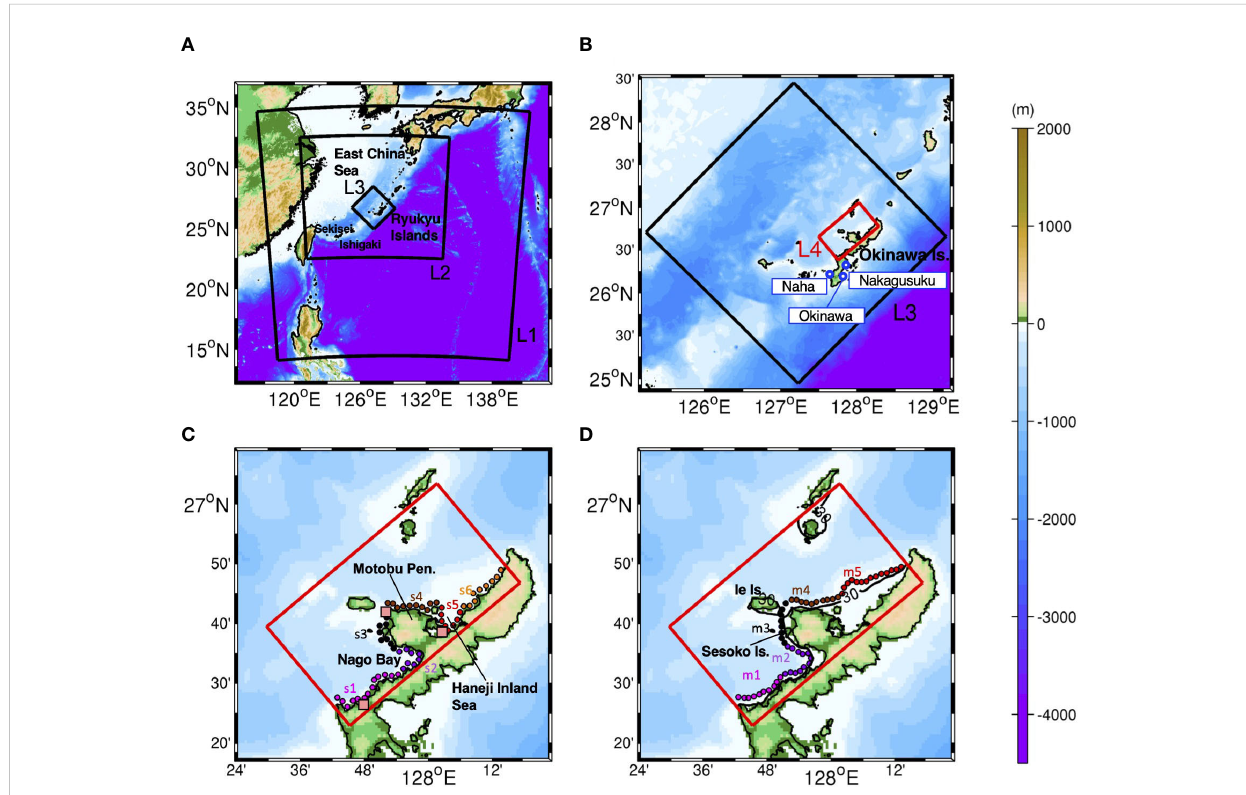
FIGURE 1 (A) The study area encompassing the entire Ryukyu Islands with the perimeter of the ROMS-L1, -L2, and -L3 models (black boxes), (B) and the ROMS-L4 model domain (red box) in the L3 domain (black box). Blue circles indicate the three tide gauge stations at Naha, Okinawa, and Nakagusuku discussed in section 2.4. (C) An enlarged plan view of the area around Okinawa Island with the source sites for particle tracking experiment Case 1 (shallow release from a depth of 2 m). The circles indicate 57 source and destination patches with a diameter of 500 m, which are further grouped into areas s1 – s6. The pink squares indicate the virtual tide gauge stations for comparisons between the L3 and L4 tides in section 2.4. (D) Same as (C) , but for Case 2 (mesophotic release from a depth of ~30 m). The circles indicate 54 source and destination patches to be grouped into areas m1 – m5. The black solid line is the isobath at a 30 m depth. The red rectangles correspond to the L4 domain in (B – D) . Colors show bathymetry in